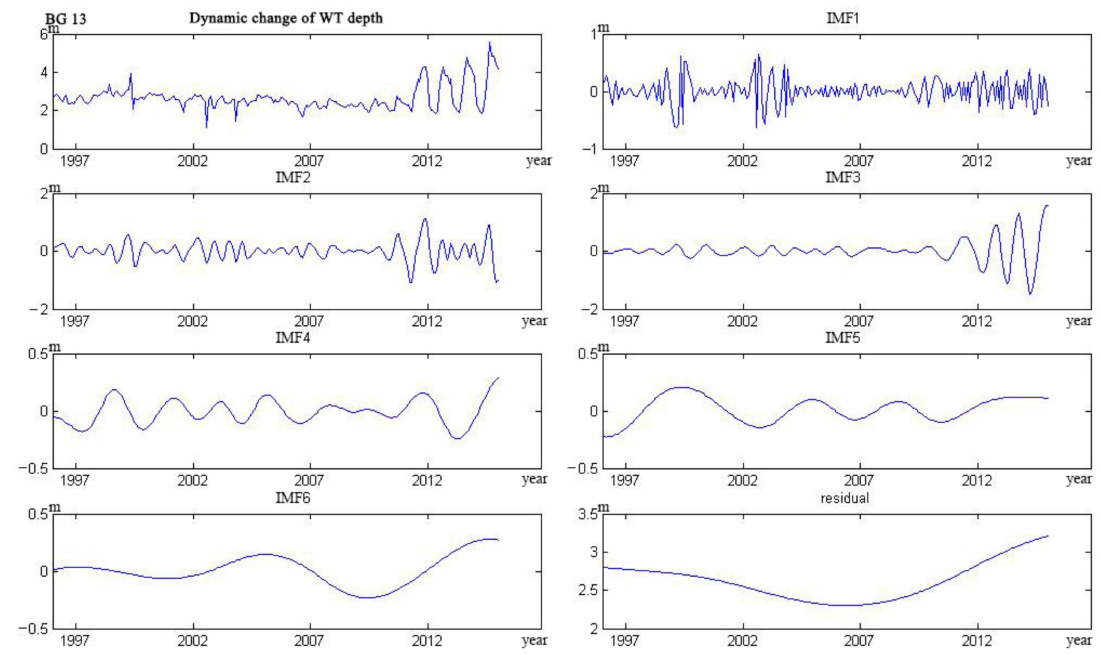
Figure A10. Decomposition of groundwater time series data of well